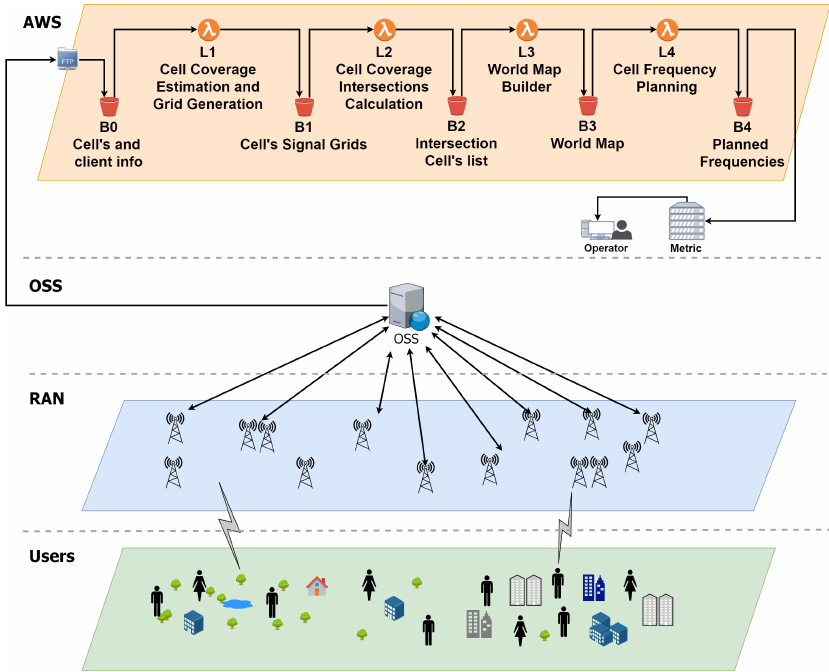
Figure 11. AWS cloud services integration on work